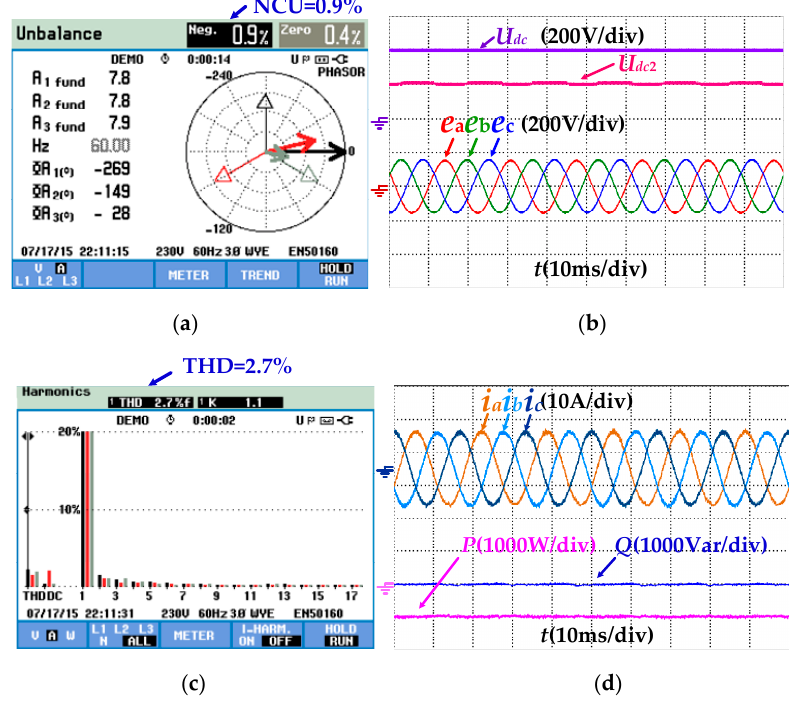
Figure 15. Experimental results of proposed MPDPC for fault-tolerant BVSC in rectifier mode with leg faults of phase a ( a ) negative current unbalance; ( b ) voltage waveform; ( c ) harmonics spectrum; ( d ) current and power